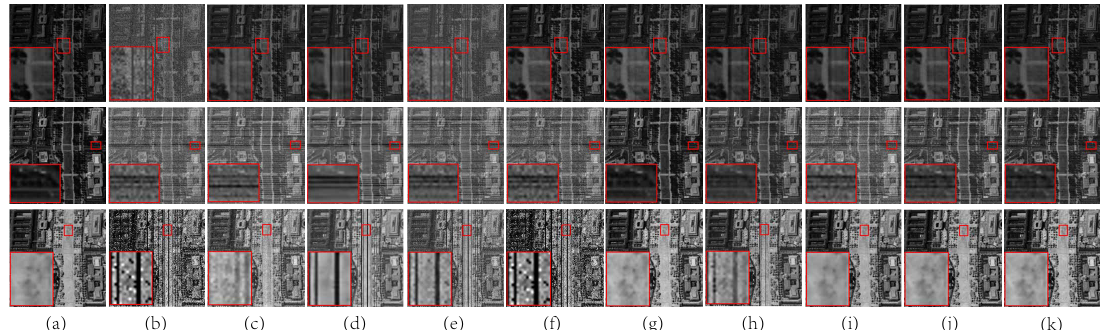
Figure 4. From top to bottom: restoration results of band 118, 20 and 66 of the DCmall HSI dataset under case 3, case 4 and case 6, respectively. ( a ) Original HSI; ( b ) Noisy HSI; ( c ) SVD; ( d ) BM4D; ( e )